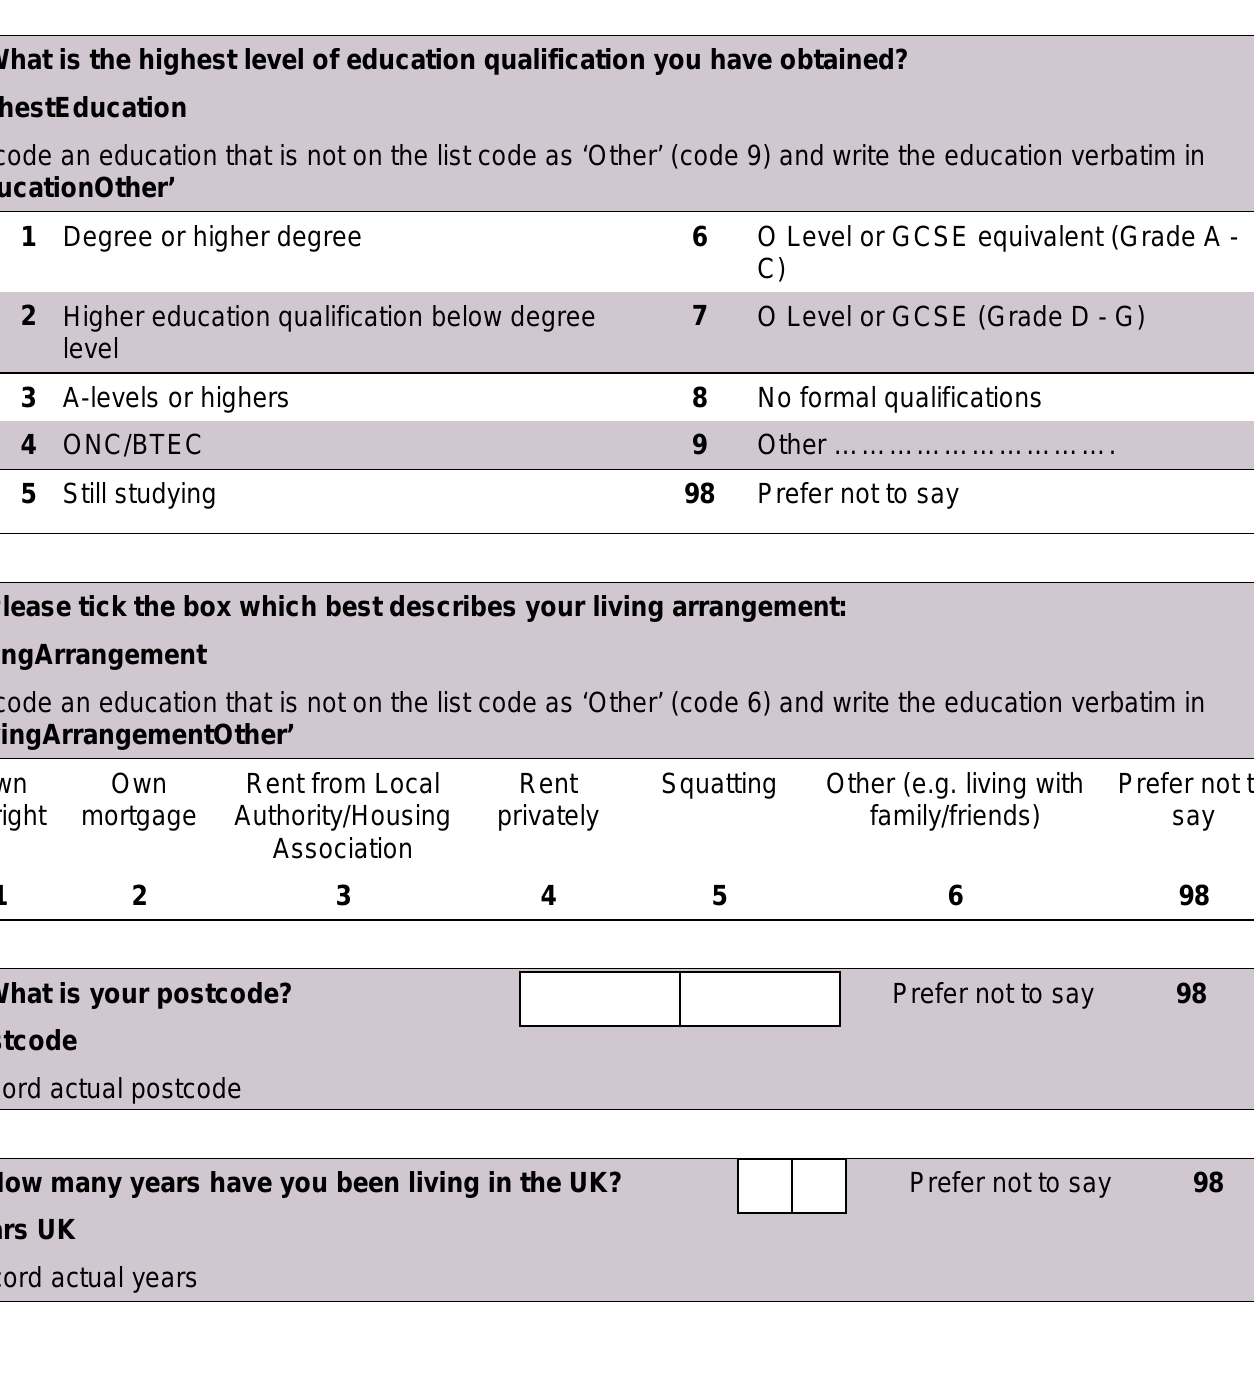
Cervical Cancer Awareness Measure Toolkit Version